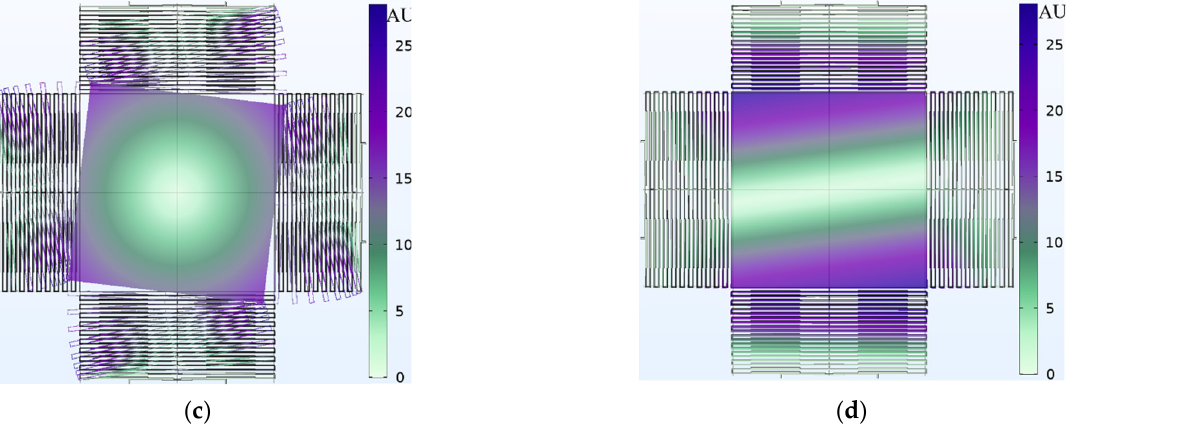
Figure 9. The mechanical resonance frequencies of the mass-spring system for design 3 ( a ) mode 1 lateral movement with resonance frequency 367 Hz, ( b ) mode 2 vertical movement with resonance frequency 428 Hz, ( c ) mode 3 rotational movement with resonance frequency 744 Hz, ( d ) mode 4 off-axis movement with resonance frequency 875 Hz.